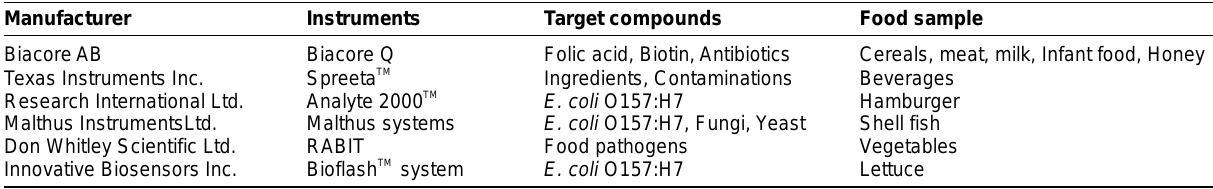
Table-3. Upcoming biosensors in near future (The names of commercial products/companies used in this study are for information purpose only. Authors or institute of authors do not recommend the use of these products) Company